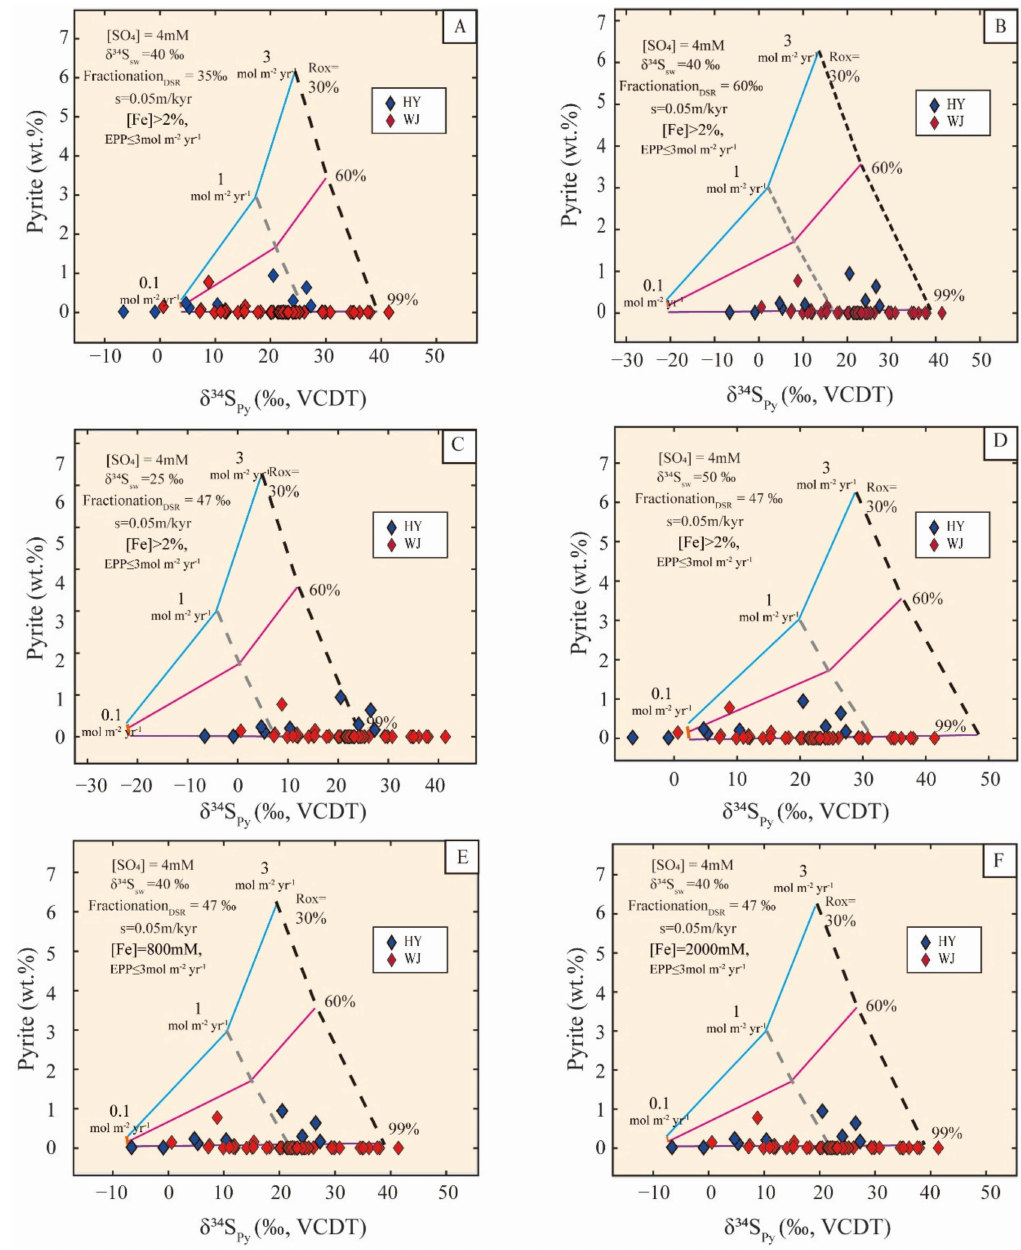
Figure 7. The 1D-DAR model sensitivity tests of variable δ 34 S sw , [Fe] 0 , and biological fractionation. ( A ) and ( B ) show the modeling results of different biological fractionations. ( C ) and ( D ) show the modeling results of different δ 34 S sw values. ( E ) and ( F ) show the modeling results of different [Fe] 0 values. The data in the Wangji section are taken from [82]. The blue, pink, and purple solid lines indicate that the proportion of H 2 S reoxidation was 30%, 60%, and 99%, respectively. The orange, gray, and black dashed lines indicate that the organic matter flux was 0.1, 1, and 3 mol/m 2 /yr, respectively. The boundary conditions of the model are shown in the figures. The data in the Wangji section are taken from